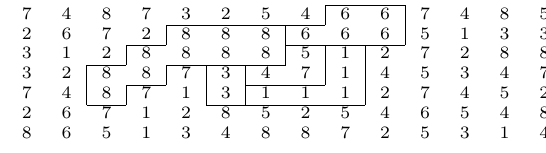
Table 2. Tiling map generated by the original CSHD algorithm with highlighted groups of same tiles.